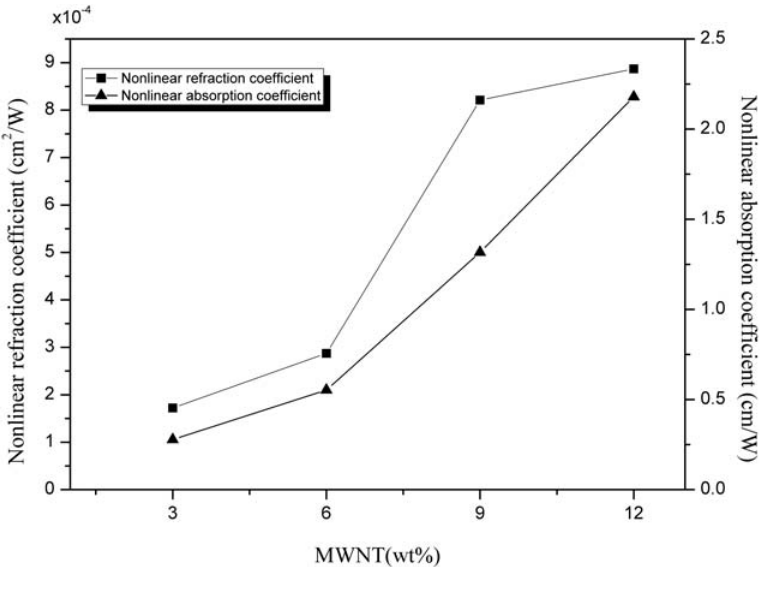
Figure 6. Variation of the nonlinear refraction coefficient and nonlinear absorption coefficient for different MWNT (wt %)